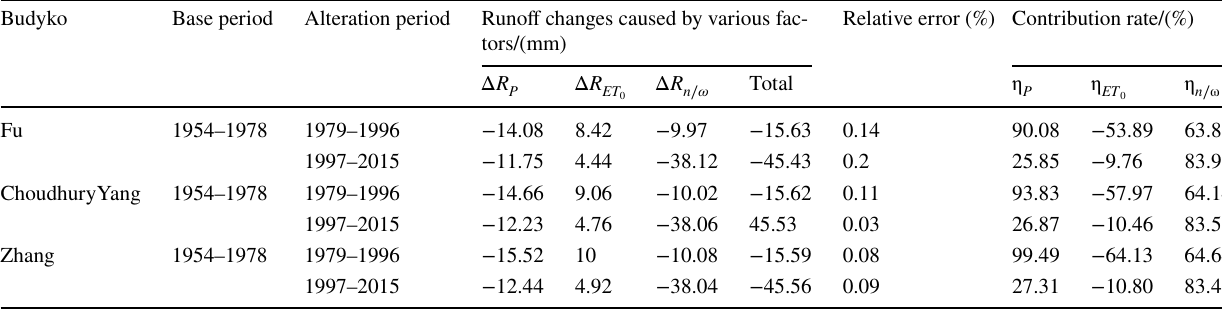
Table 6 Contribution rate of runoff variation in Huangfuchuan River basin calculated by complementary method